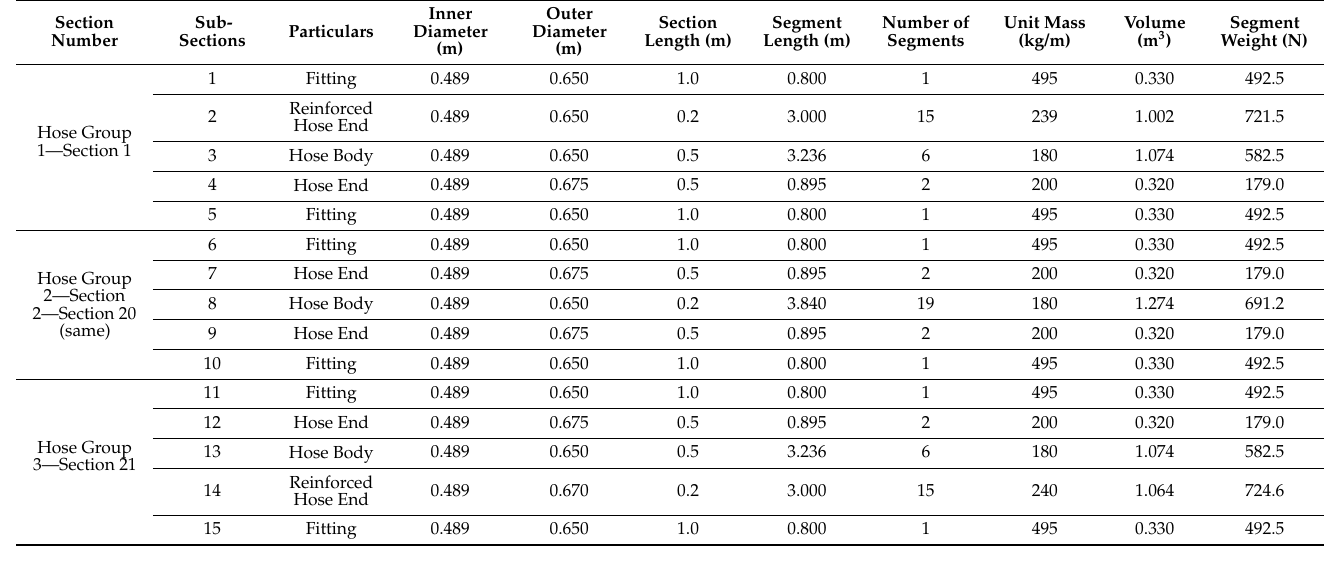
Table 2. Submarine Hose Arrangement with section details.